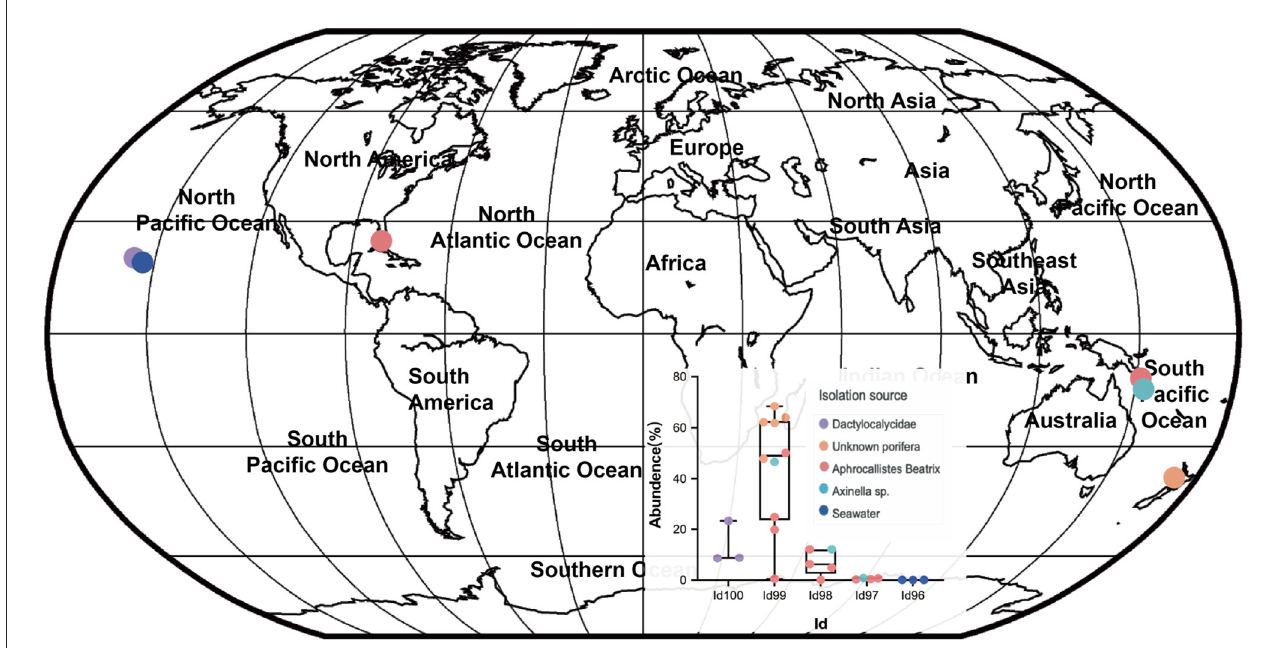
FIGURE4 Global distribution of the sponge symbiont Nitrososphaerota B01. To investigate the distribution of B01 in sponges and surrounding environmental samples, its 16S rRNA gene sequence as a query was searched against the Sponge Microbiome Project (SMP) using BLASTN, and the target sequences with identity values of > 96% were selected and assigned to Id100 (identity = 100%), Id99 (identity ≥ 99% but < 100%), Id98, Id97, and Id96 groups. The relative abundance of the B01 relatives in the SMP samples was calculated. Target sponge species and environmental samples were labeled on the world